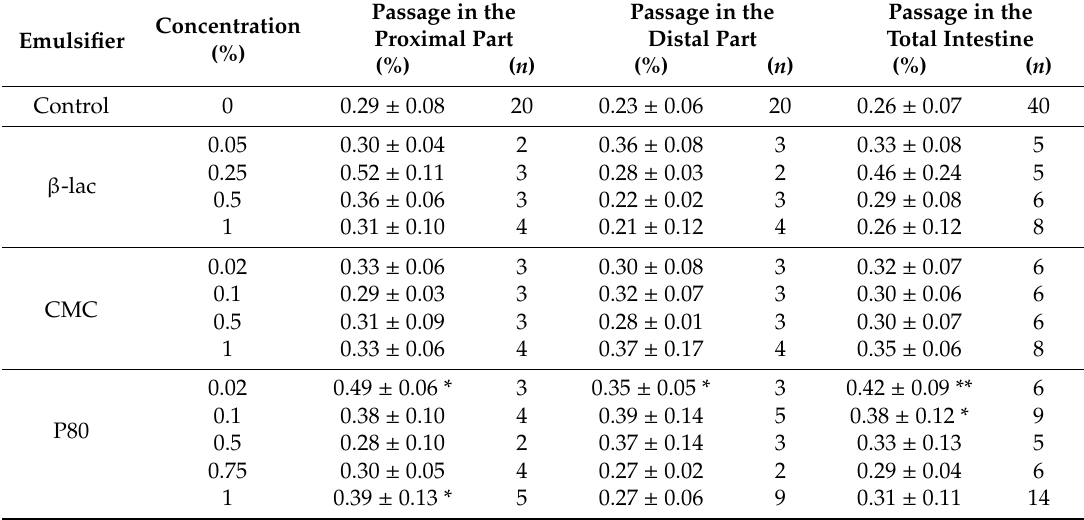
Table 2. The passage of the marker molecule FITC-dextran in both the proximal part, the distal part, and the total (proximal and distal part together) small intestine at 120 min after the start of the experiment for the di ff erent emulsifiers at di ff erent concentrations. The values are presented as the mean ± standard deviation together with the number of replicates ( n ). The p -values are calculated based on di ff erences in kinetics detected by the AUC analysis compared with the control. Passage in the Passage in the Passage in the Concentration Proximal Part Distal Part Total Emulsifier (%)